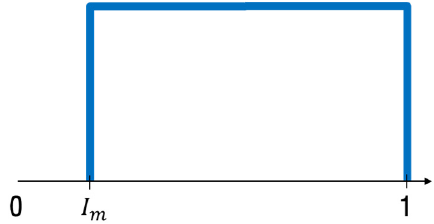
Figure 4. Distribution of magnitude-modifying factor.